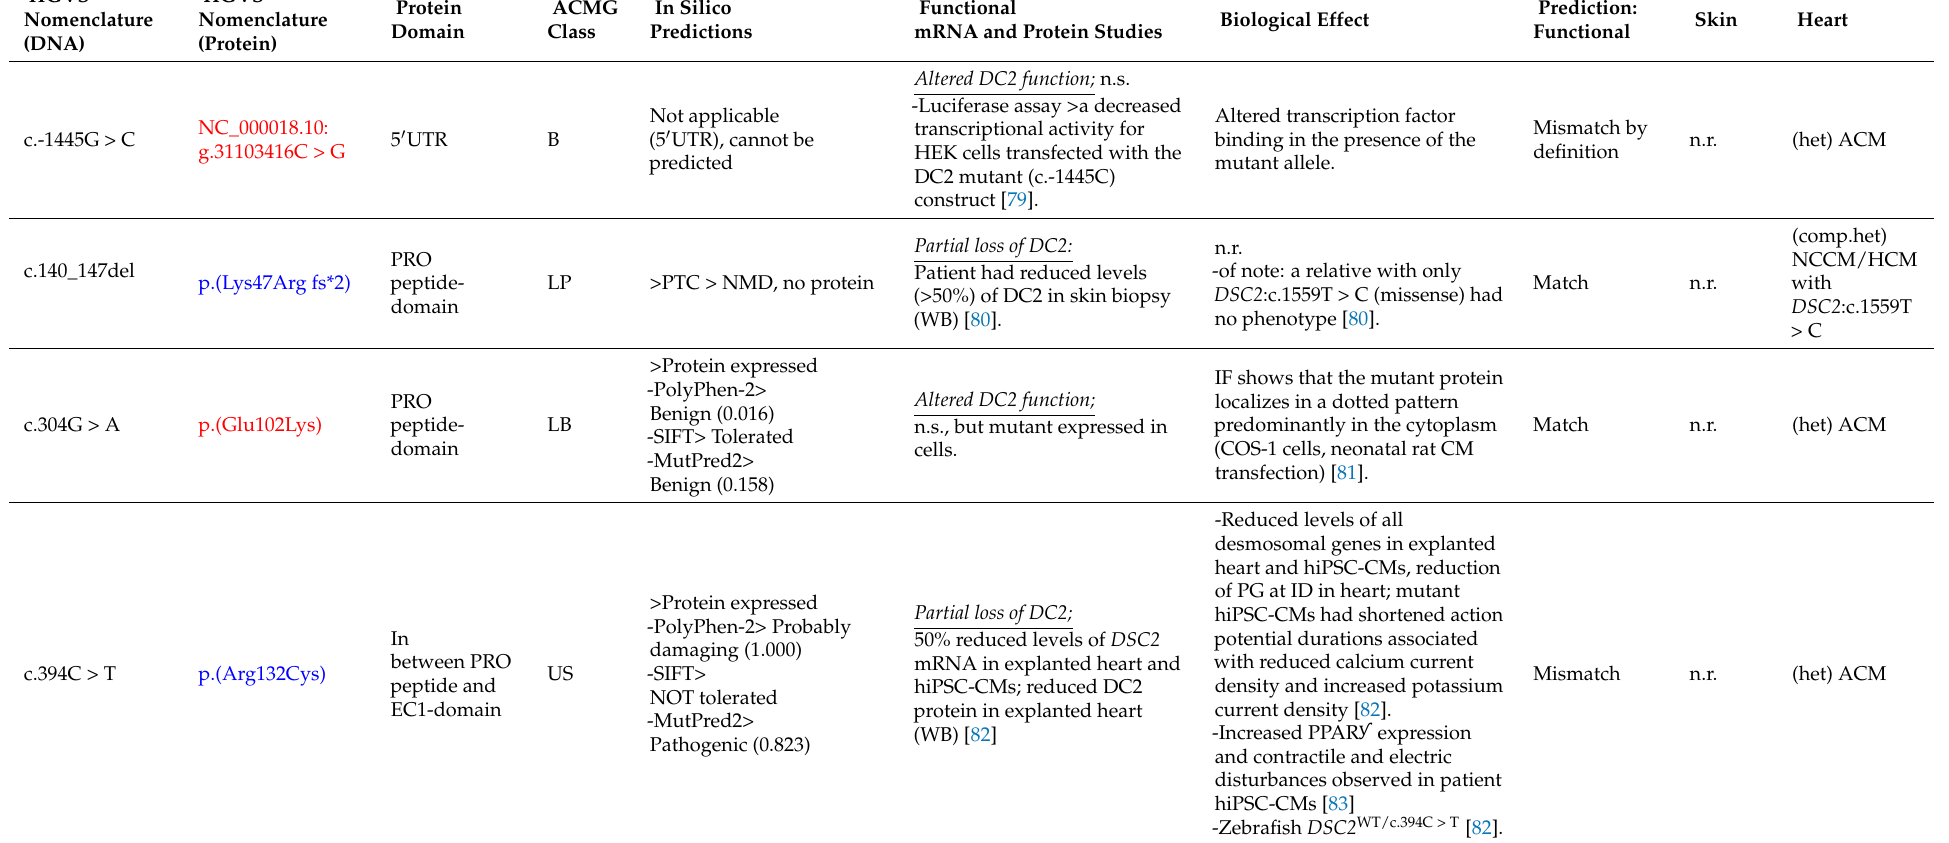
Table 3. Functionally analysed DSC2 variants.